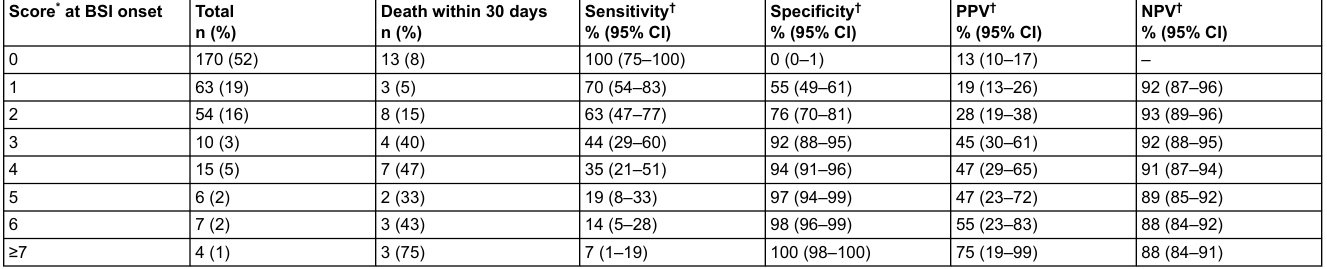
Table 2: Sensitivity, specificity, and predictive values of the Pitt Bacteraemia Score for prediction of 30-day all-cause mortality in Staphylococcus aureus bloodstream infection (n = 329). Score * at BSI onset Total n